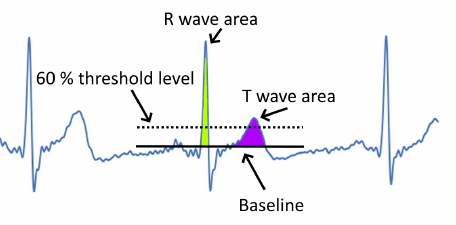
Figure 3. Illustration of two approaches for distinguishing the R and T waves on the signal of ECG (blue line) based on the width and area ((painted green for T and purple for T wave) of the